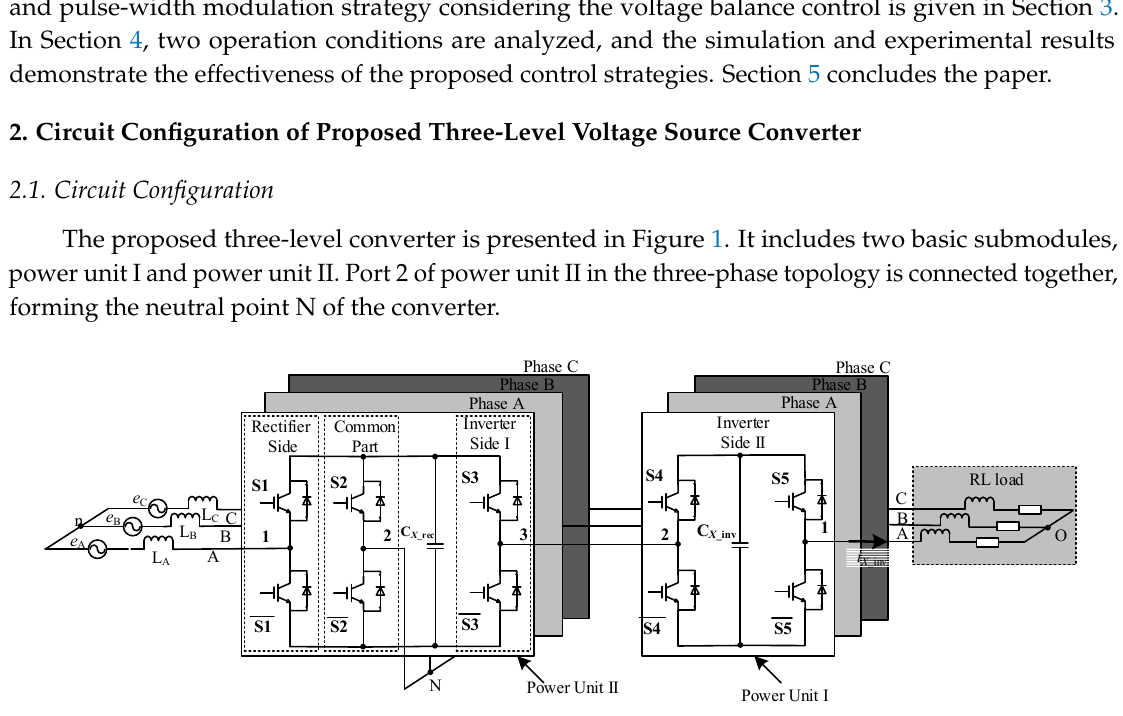
Figure 1. Circuit configuration of the proposed three-level voltage source converter.